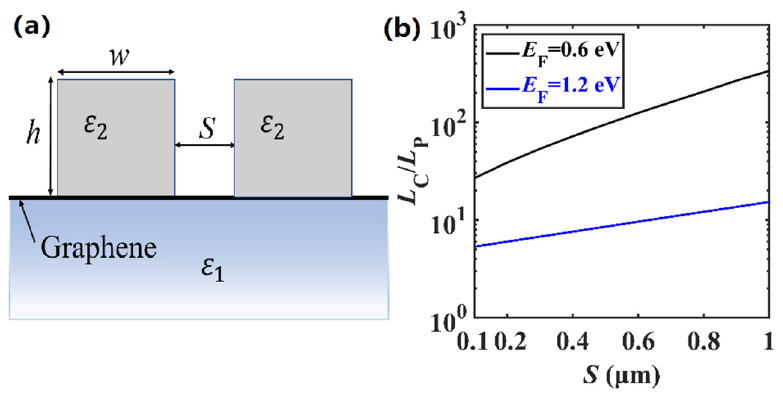
Figure 8. ( a ) Coupling system with two DLGSPWG structures; and ( b ) Normalized coupling length L C / L P with respect to S at different E F values. w = 4 μ m, h = 4 μ m, and f 0 = 5 THz.